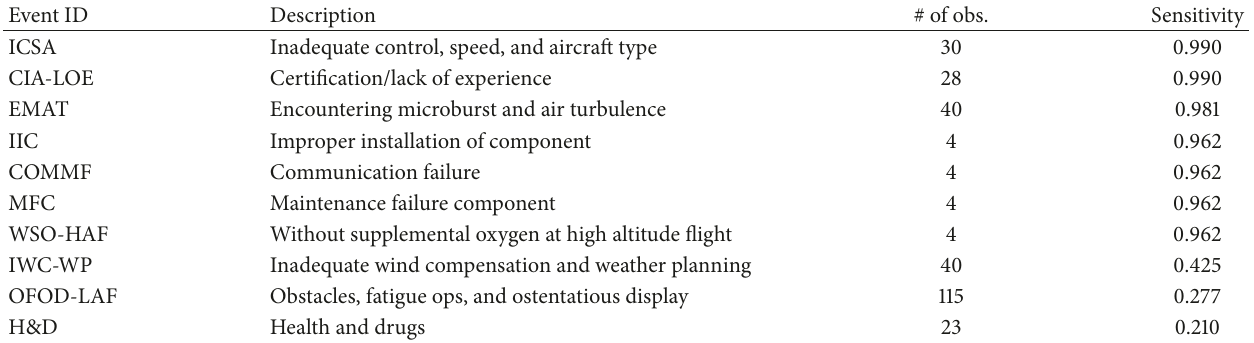
Table 6: CCF top ten events’ sensitivity results for accident